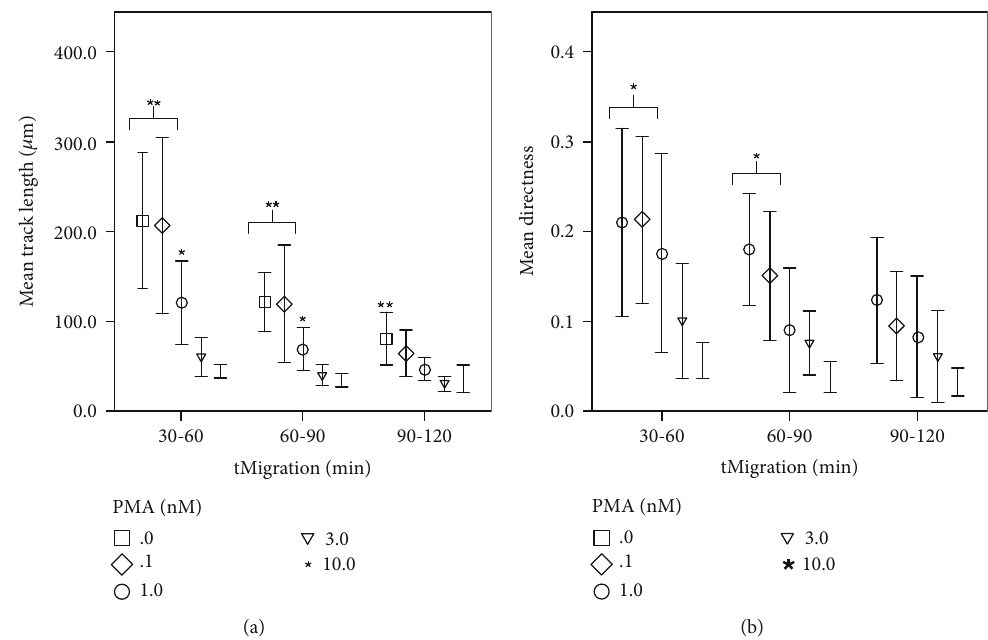
Figure 2: Track length and directness decrease during time-lapse and PMA. x -axis: 30-minute time intervals tMigration (min), y -axis: (a) mean track length ( μ m) in μ m, comparing di ff erent PMA concentrations (0 – 10nM); (b) mean directness, comparing di ff erent PMA concentrations (0 – 10nM); ∗ signi fi cant when compared to 10 nM PMA; ∗∗ signi fi cant when compared to 3 nM and 10 nM PMA; error bars represent standard deviation of